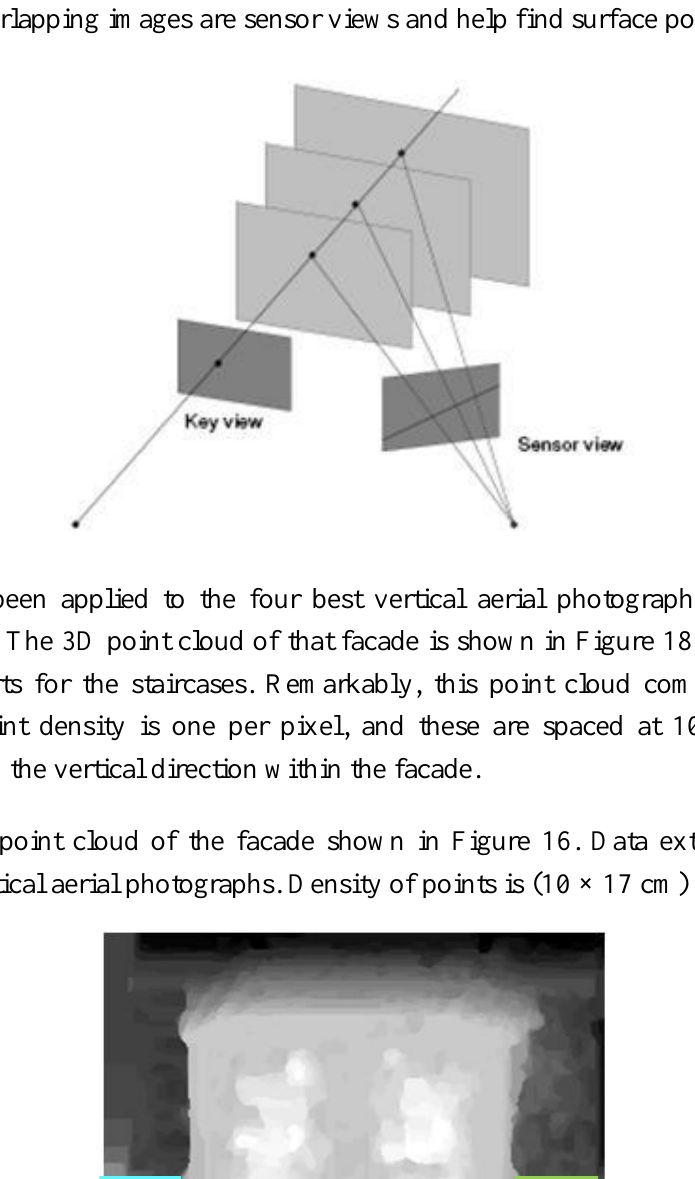
Figure 17. Our ―plane sweep‖ defines a set of parallel planes in the object space and intersects these planes with the projection rays from a key image, producing an (irregular) 3D grid. All overlapping images are sensor views and help find surface points.